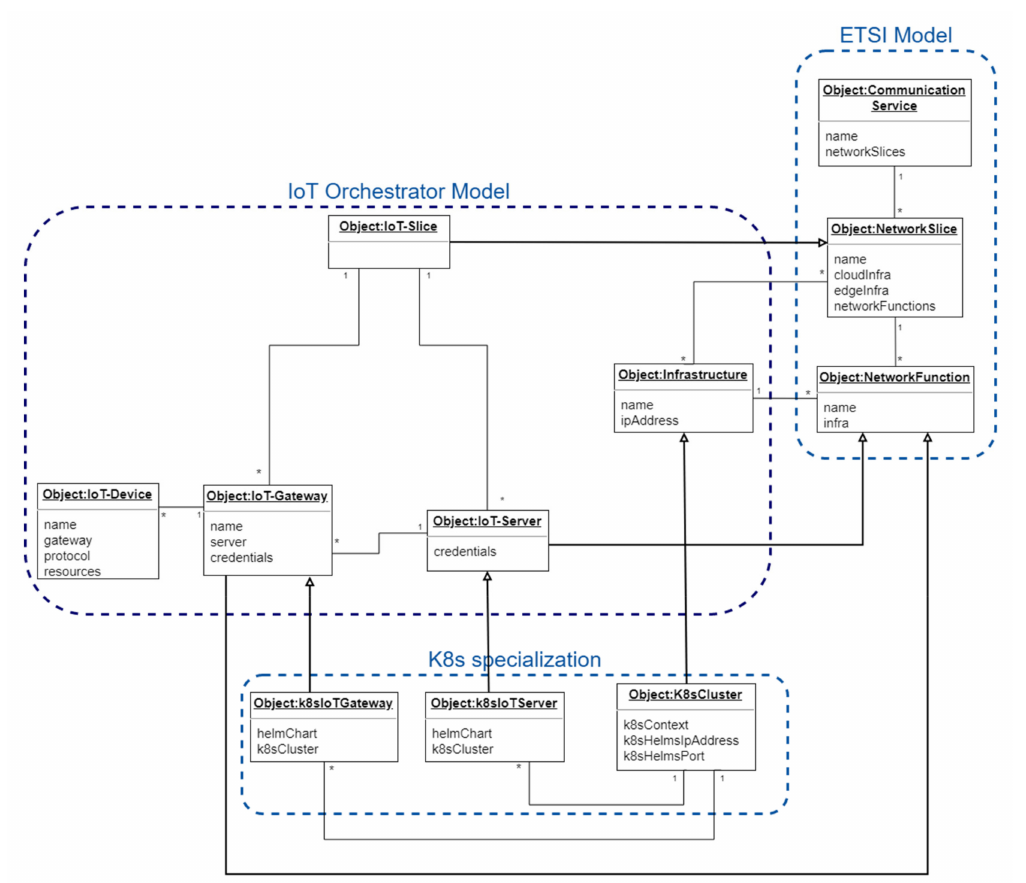
Figure 3. IoT slice orchestrator information